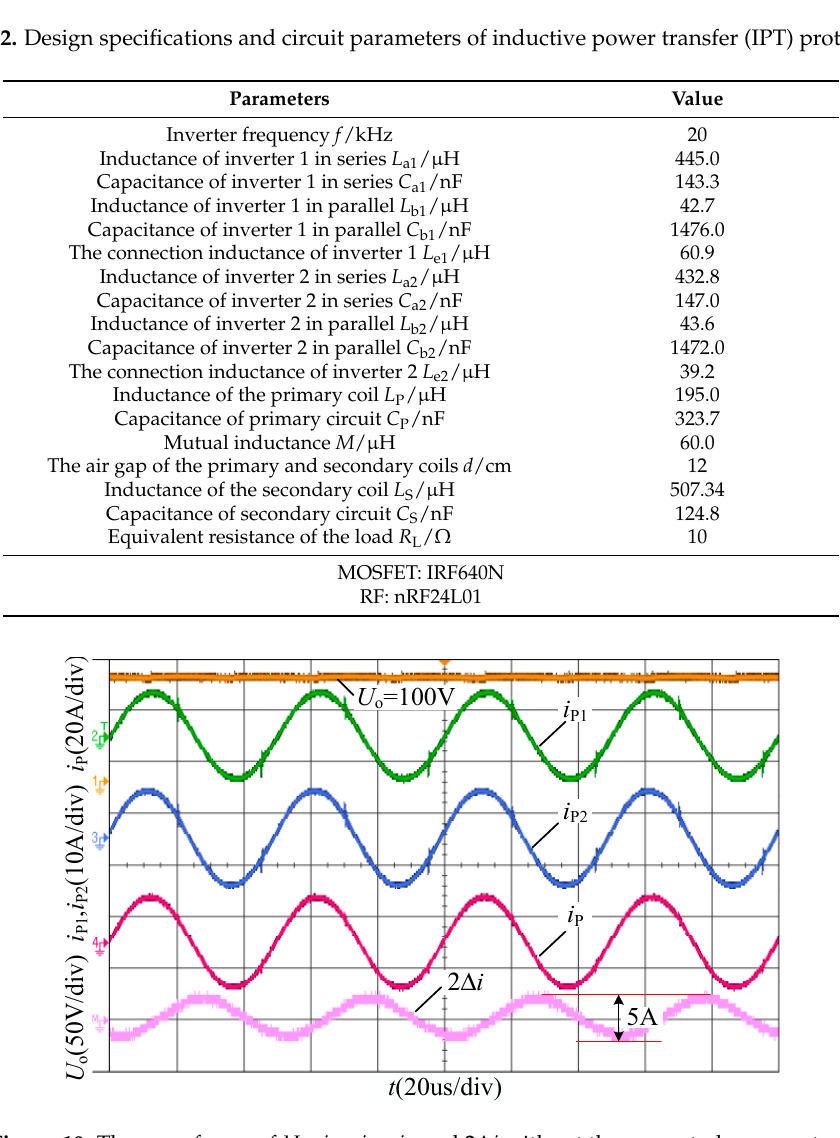
Figure 10. The waveforms of U o , i P1 , i P2 , i P and 2 i